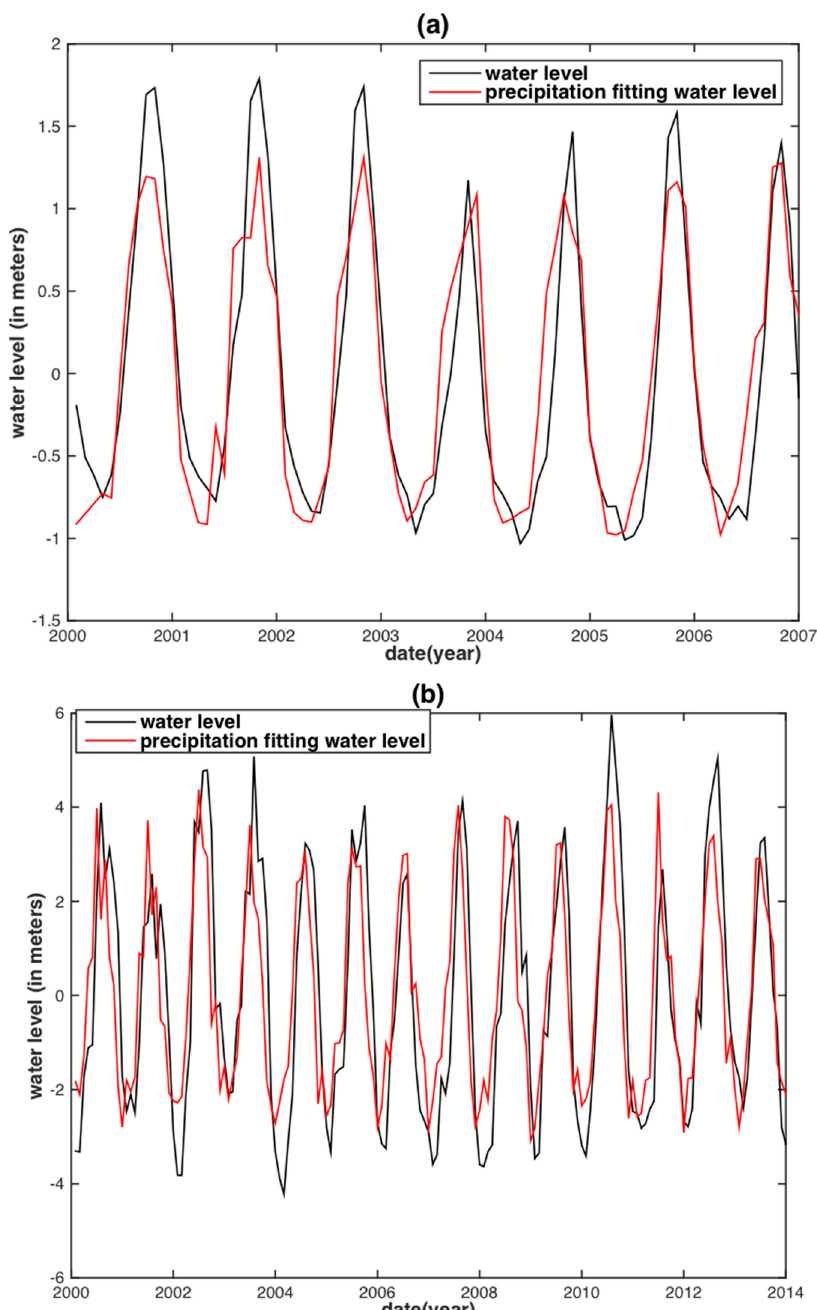
Figure 4. Water level reconstruction from basin-averaged TRMM precipitation at Vam Kenh station of the MRB ( a ) and at Datong station of the YRB ( b ).